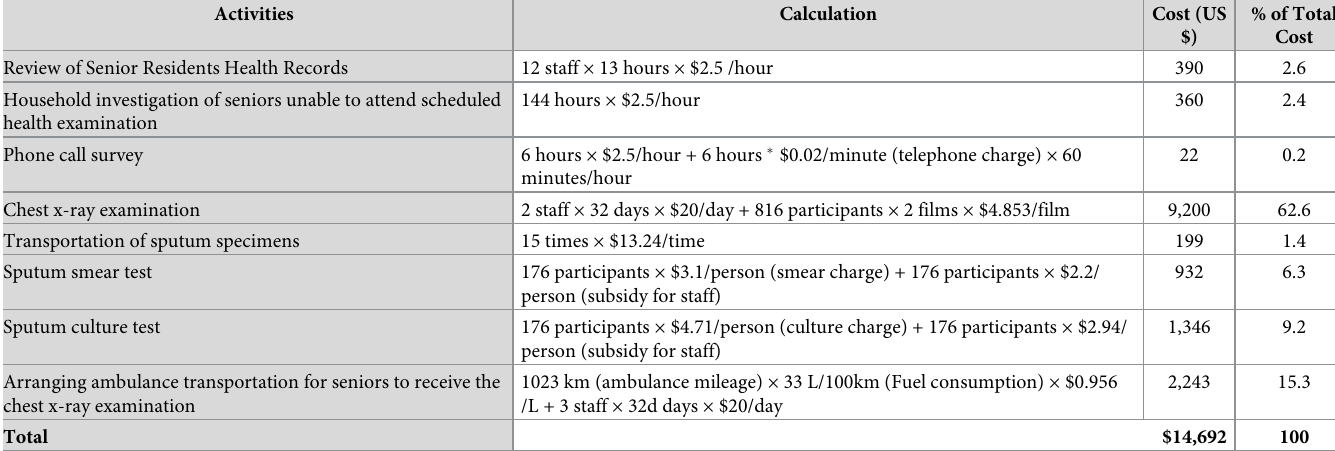
Table 3. Costs of active case finding among seniors aged � 65 years not covered by the Basic Public Health Service Program in Bayi township, Sichuan Province, China, March–June 2017.